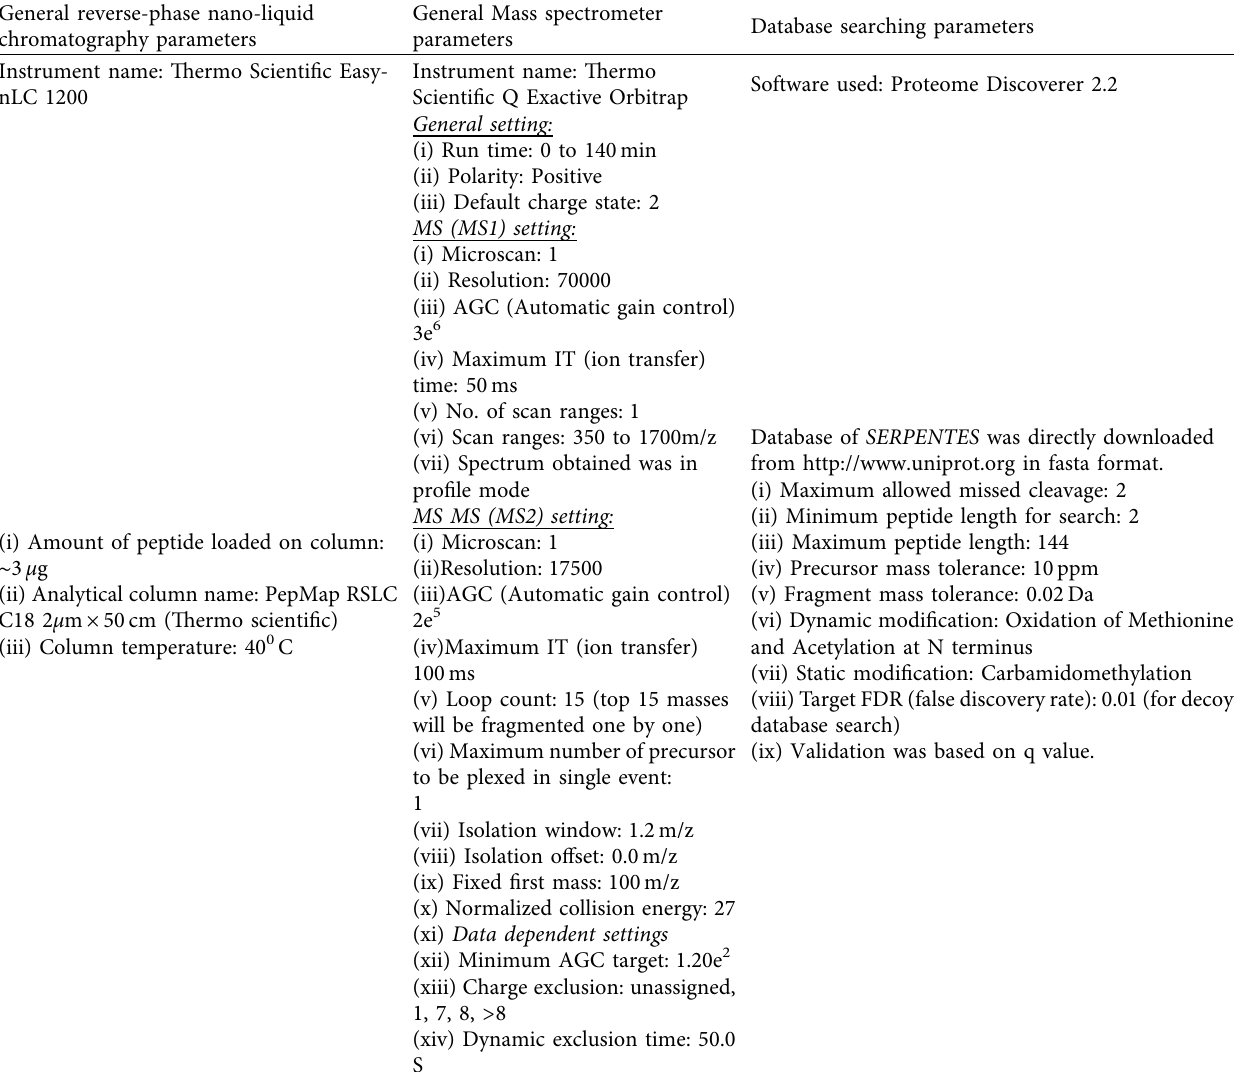
Table 1: Details of various machine and experiment parameters of LC-MS/MS analysis of snake